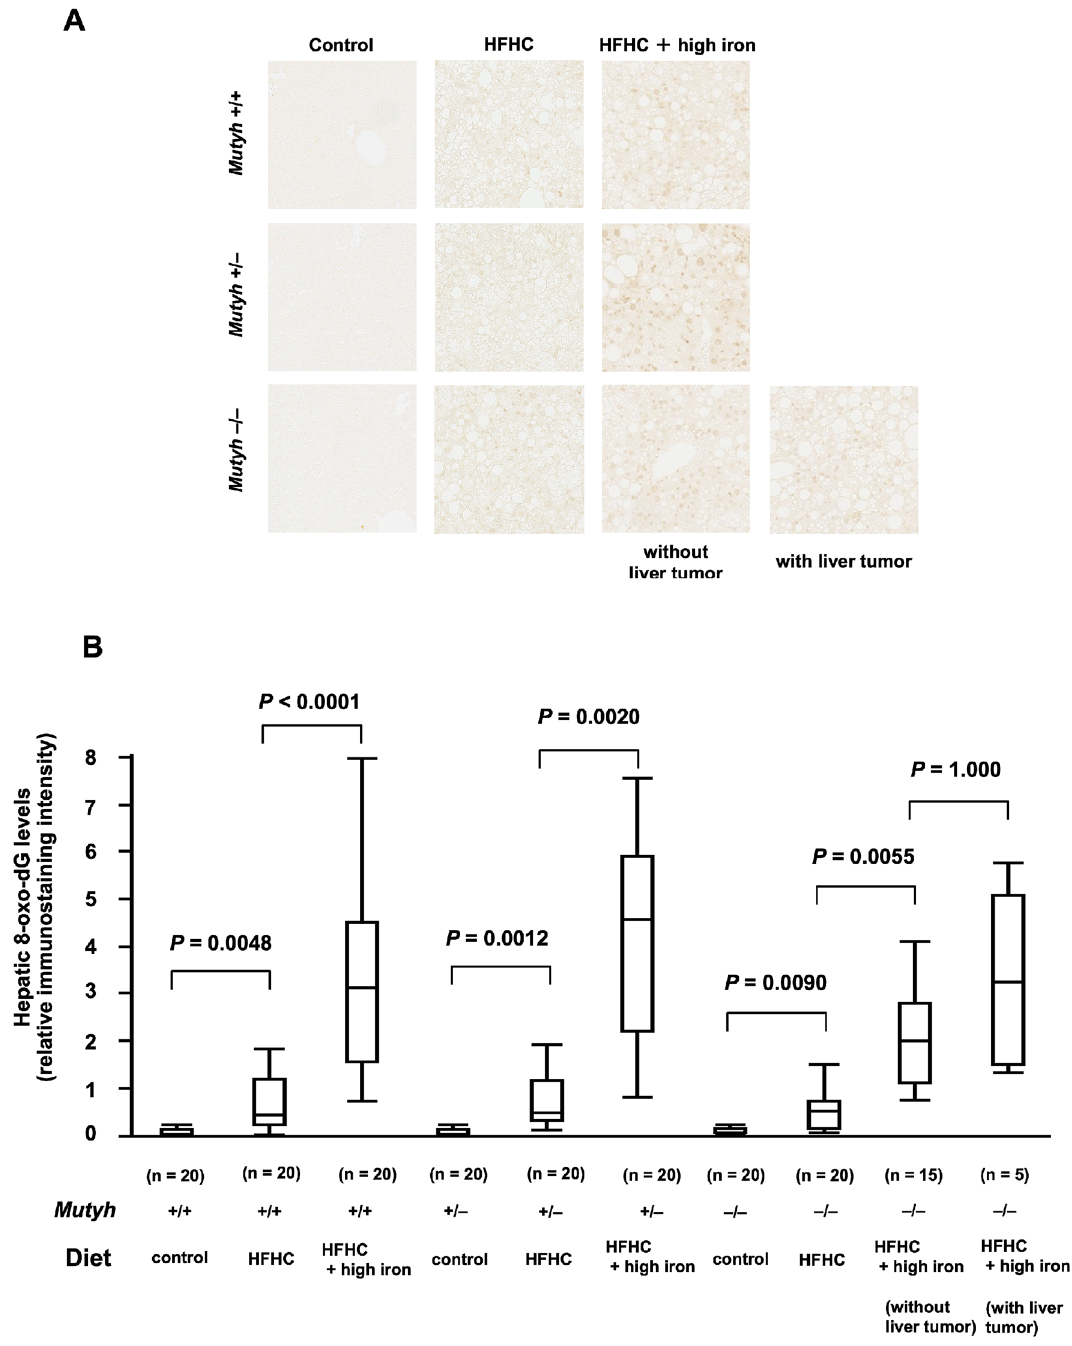
Figure 5. Liver sections stained with anti-8-oxo-dG antibody. ( A ) Immunostaining of mouse livers with anti- 8-oxo-dG antibody. ( B ) Semiquantative score of 8-oxo-dG immunostaining. Scores were significantly higher in the HFHC diet groups than the control diet groups ( Mutyh +/+ , HFHC diet group vs. Mutyh +/+ , control diet group; P = 0.0048, Mutyh +/− , HFHC diet group vs. Mutyh +/− , control diet group; P = 0.0012, Mutyh −/− , HFHC diet group vs. Mutyh −/− , control diet group; P = 0.0090) and significantly higher in the HFHC + high-iron diet groups than the HFHC diet groups ( Mutyh +/+ , HFHC + high-iron diet group vs. Mutyh +/+ , HFHC diet group; P < 0.0001, Mutyh +/− , HFHC + high-iron diet group vs. Mutyh +/− , HFHC diet group; P = 0.0020, Mutyh −/− , HFHC + high- iron diet group vs. Mutyh −/− , HFHC diet group; P = 0.0055). There was no significant difference in the index according to the presence or absence of tumor development ( P = 1.000). Data analysed with a Kruskal–Wallis test followed by Dunn–Bonferroni test. For all data analysis P < 0.05 considered significant. Data are shown as box plots for each group of mice. Median values are shown by the line within the box. The bottom and top edges of the boxes represent the 25th and 75th percentiles, respectively. HFHC, high-fat high-carbohydrate; 8-oxo-dG,